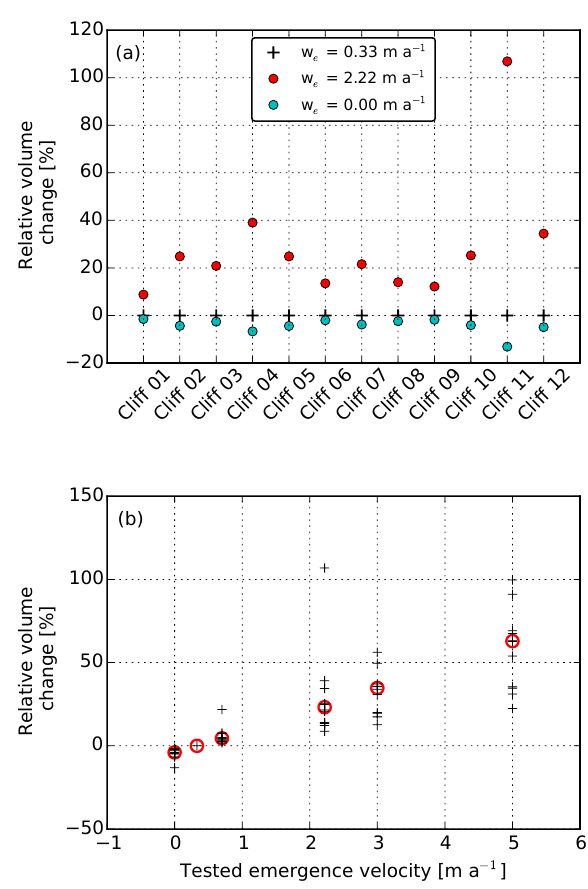
Figure 6. Sensitivity of the volume change estimate to the emer- gence velocity for each cliff with two tested emergence ve- locities (a) and for all cliffs with various emergence veloci- ties tested (b) . The relative volume change is the tested volume change minus the reference volume change (obtained for w e = 0 . 33ma − 1 ), divided by the reference volume change and multi- plied by 100. In the lower panel, each cross represents a cliff and the open circles represent the median; note that relative volume changes of cliff 11 are not visible for emergence velocities of 3.0 and 5.0ma − 1 , because they are equal to 153% and 255%. The volume estimates are from terrestrial photogrammetry data for the period November 2015–November 2016.